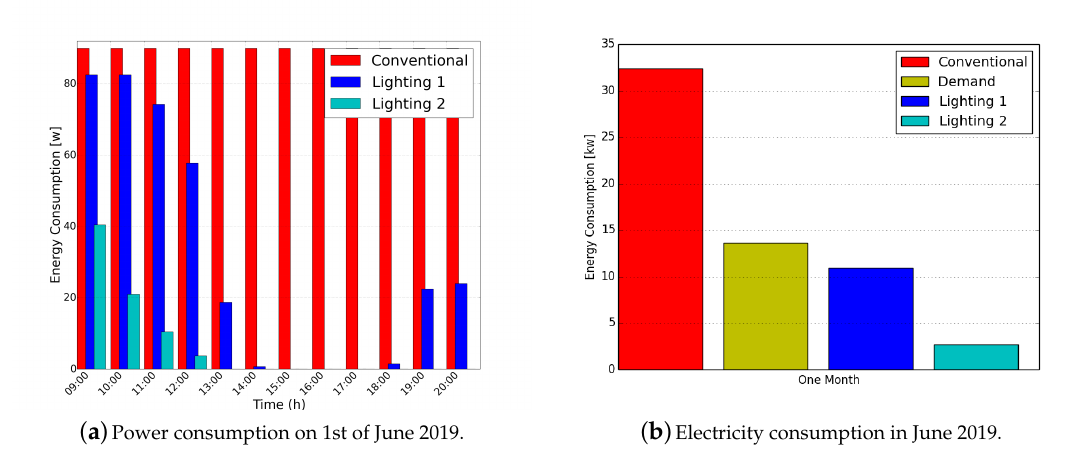
Figure 9. Electricity consumption by different LEDs and